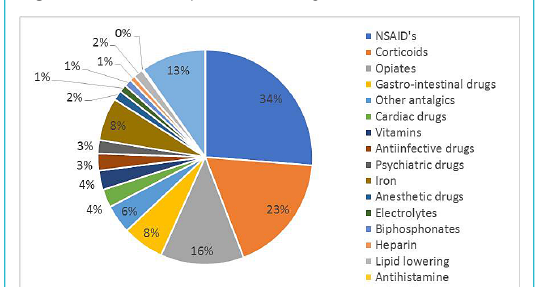
Figure 2: Medications prescribed during home visits, n = 4020.